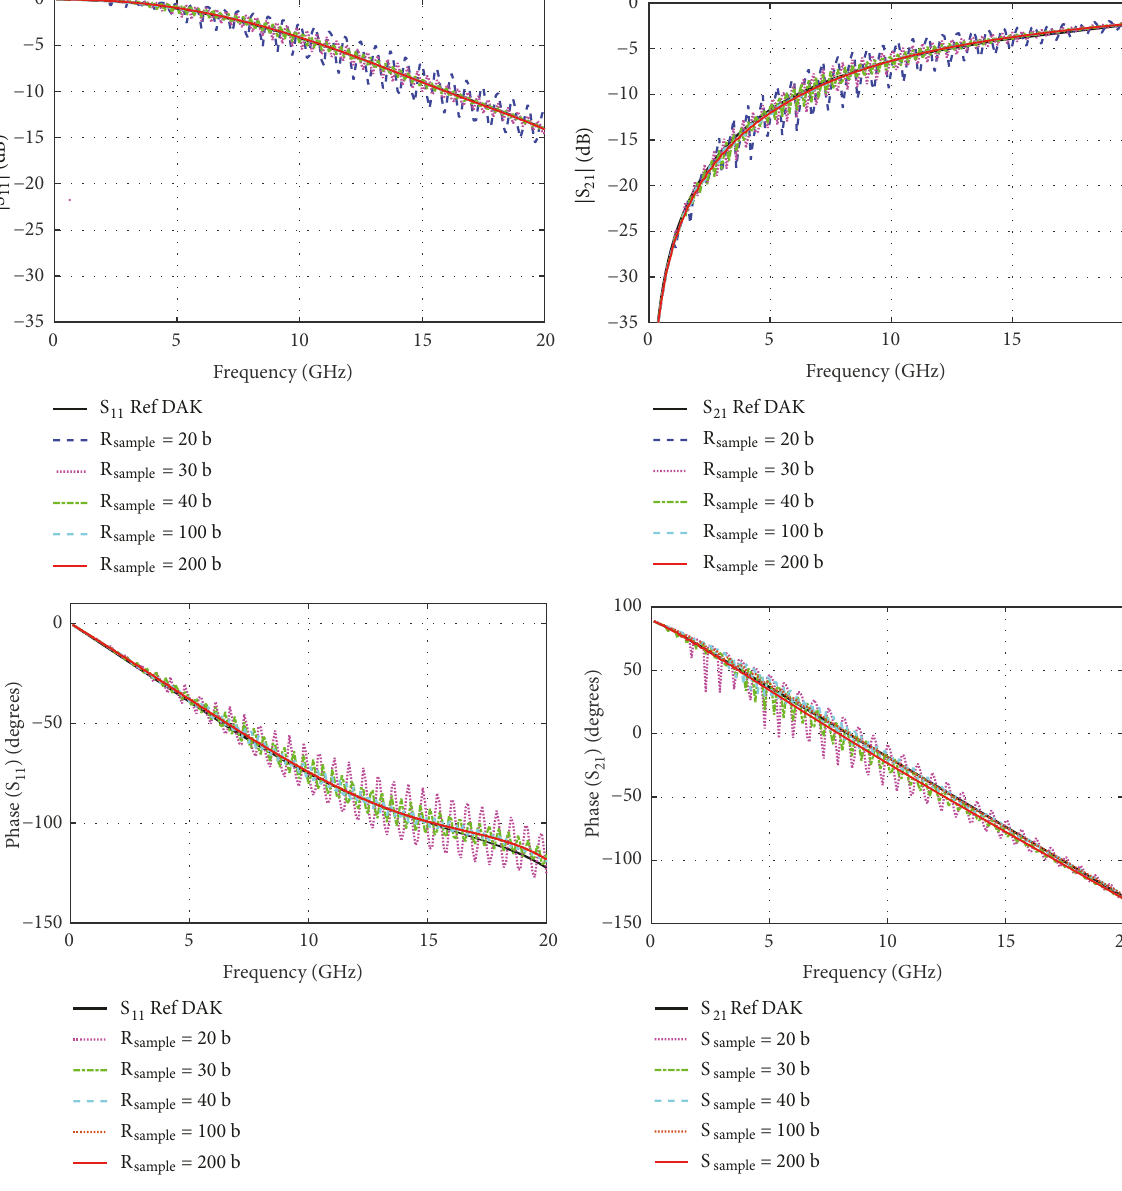
modes at the input/output coaxial lines, for n